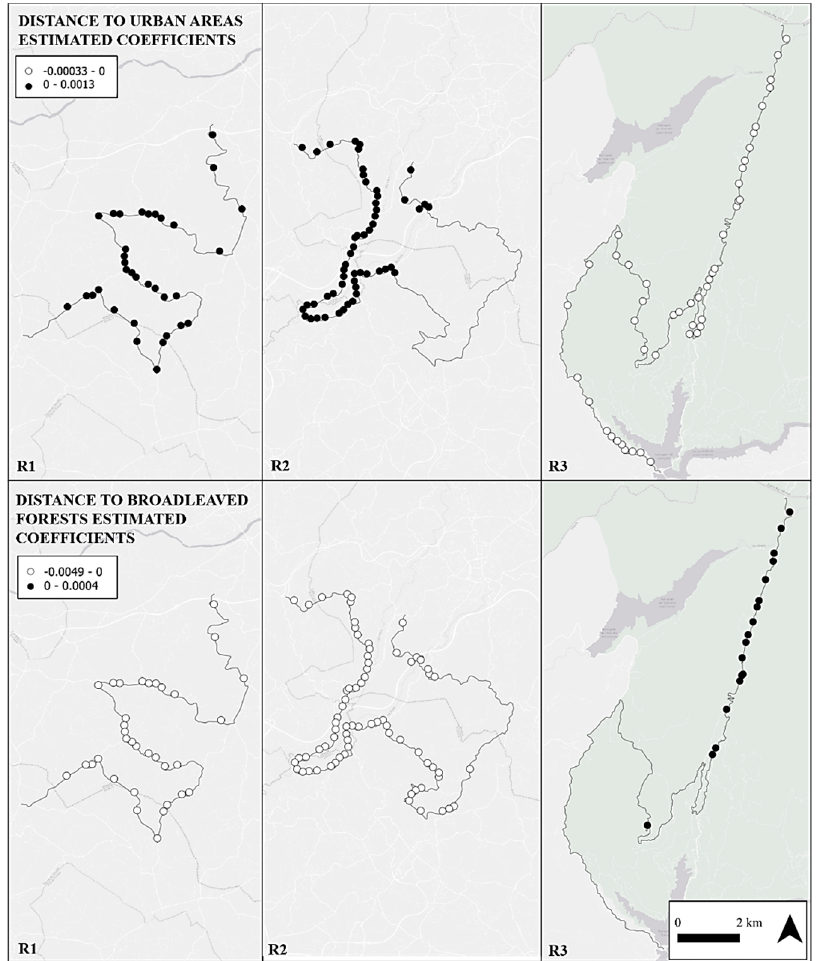
Figure 5. Estimated significant coefficients ( p < 0.05) of two variables obtained with the GWR technique in the three roads: distance to urban areas (at the top) and distance to broadleaved technique in the three roads: distance to urban areas (at the top ) and distance to broadleaved forests forests (at the bottom). White points represent the locations with negative coefficients and black (at the bottom ). White points represent the locations with negative coefficients and black points points represent the locations with positive coefficients. represent the locations with positive